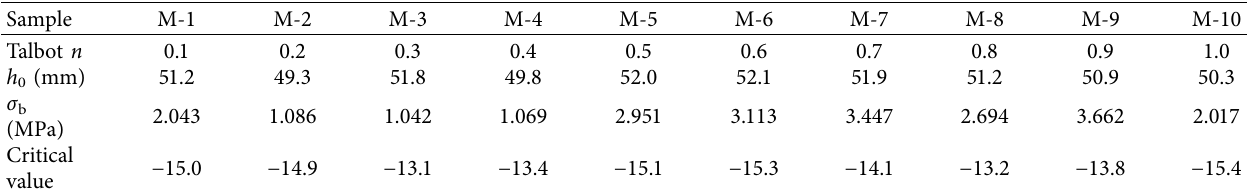
Figure 5: Schematic diagram of different stages of triaxial seepage. Table 2: Coal sample test